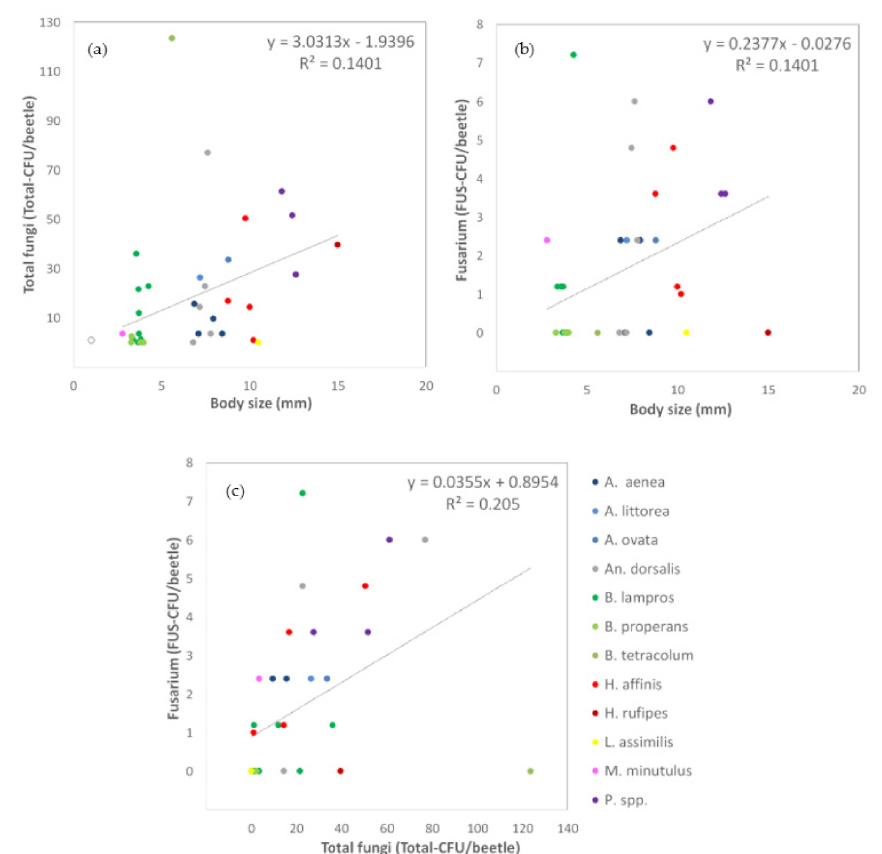
Figure 3. Effects on fungal load (colony forming units, CFU), detected on the body surface of carabid beetles with a culture- dependent method. ( a ) Effect of the body size (mm) of the carabid beetles on the load of total fungi (Total-CFU/beetle), ( b ) Effect of the body size (mm) of the carabid beetles on the load of Fusarium (FUS-CFU/beetle), and ( c ) the load of total fungi (Total-CFU/beetle) on the load of Fusarium (FUS-CFU/beetle). Carabid species are indicated in different colors in Figure 3c. Species code according to Table 1 (abbreviations long). The dotted lines show a linear trend combined for all carabid